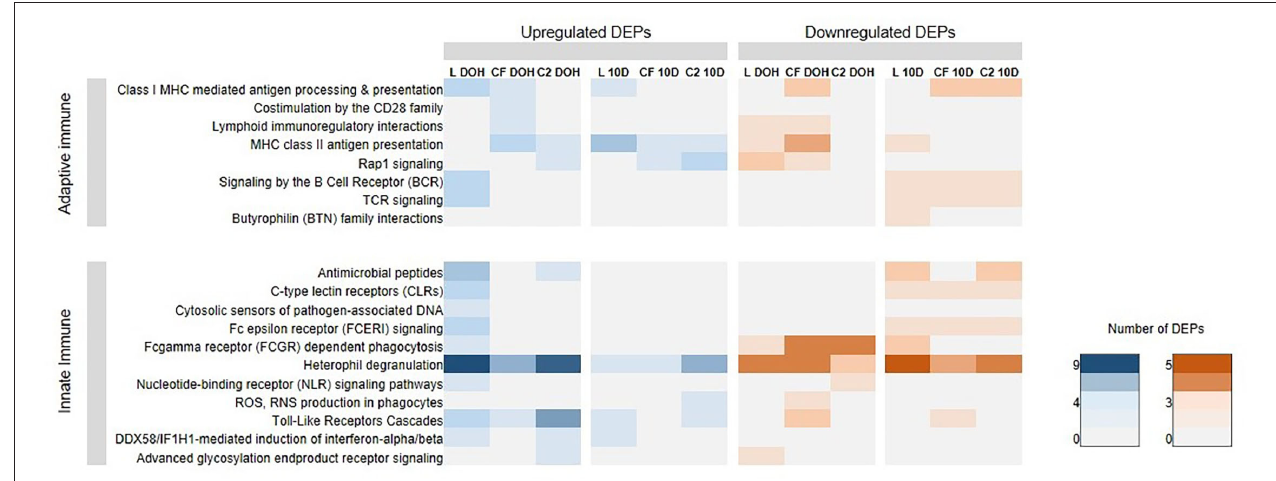
FIGURE 5 | Reactome Pathways analyses, at the day of hatch (DOH) and 10 days of age (10d), related to immune response based on differentially expressed proteins (DEPs) in intestinal samples of broilers treated with lactic acid bacteria (L), Citrobacter freundii (CF) or Citrobacte r spp. (C2).